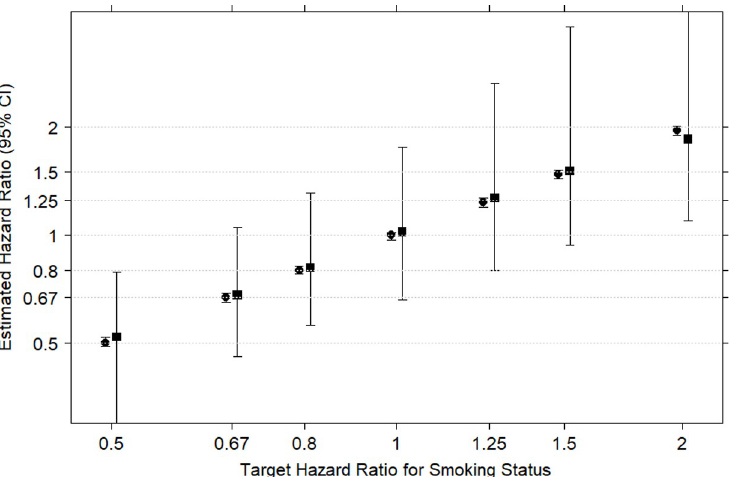
Fig 1. Results from 100 simulated data sets each with the same sample size and proportion of smokers as the SEER cancer registry data. Each simulated data set contains seven different survival times associated with the target HRs on the horizontal axis. The vertical axis shows median and 95% empirical CIs of estimated HRs arising from Cox models. The first CI in each pair is obtained from fitting designated ‘true’ smoking status as a predictor of survival using the standard Cox model. The second is obtained from fitting designated ‘imputed’ smoking status using Cox regression with corrected score estimation (the I2C2 algorithm).